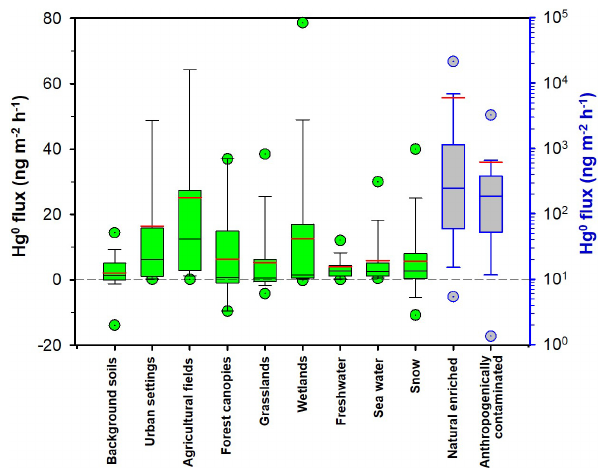
Figure 6. Box and whisker plots of global field-observed Hg 0 fluxes obtained from various landscapes. (Data source: Table 1. Red line and black line indicate mean and median